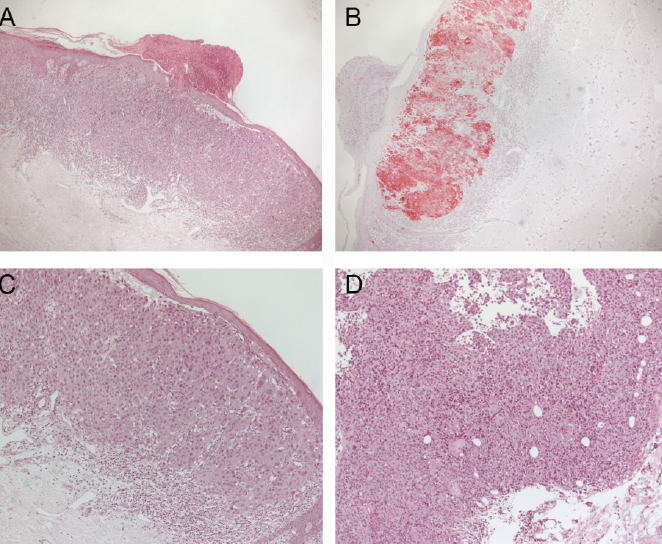
Figure 1. Histopathological samples from primary melanoma lesions ( A – C ) and subcutaneous metastasis prior to initiation of combined checkpoint inhibitor therapy in patient #1. Initial diagnosis of melanoma was confirmed in February 2016 using H&E (5 × in ( A ) and 10 × in ( C )) and IHC stains for Melan-A ( B ). Upon diagnosis of advanced stage melanoma, a biopsy from a subcutaneous lesion in the abdominal skin region confirmed advanced stage melanoma (10 × in ( D )). Both histopathological samples showed a strong infiltration by lymphocytes in the tumor-surrounding stroma.